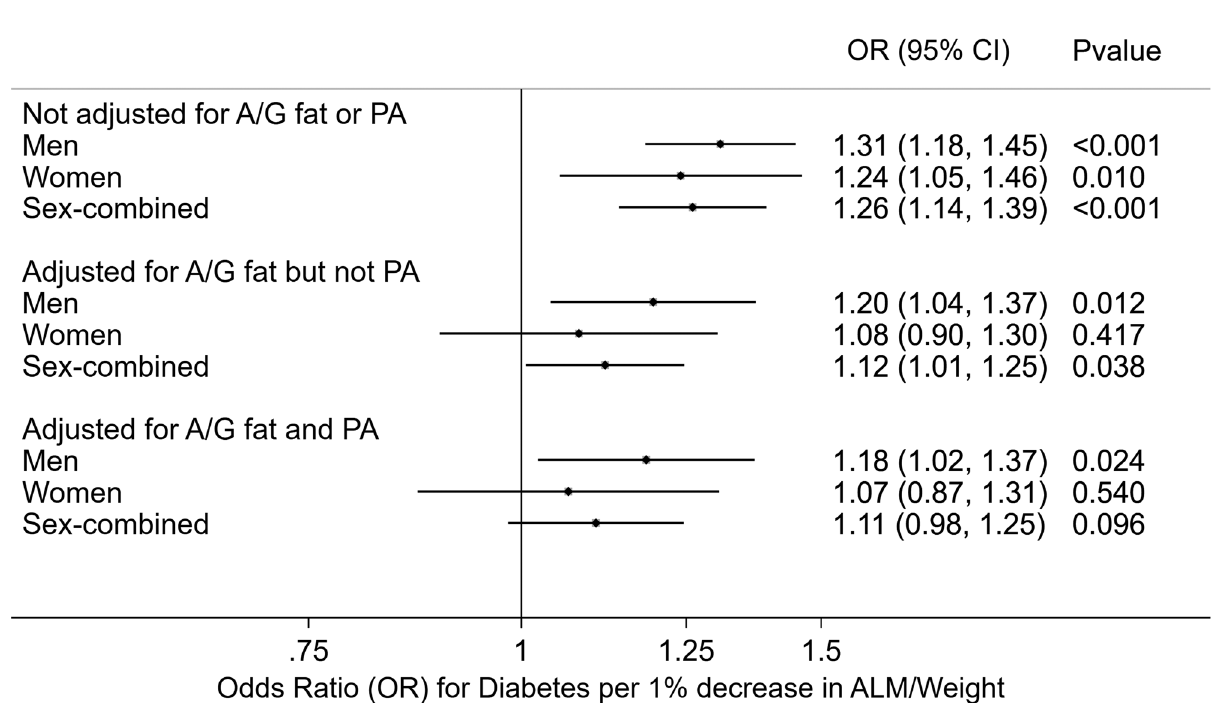
Grey boxes signify correlations in men. White boxes signify correlations in women. All correlations are signi fi cant at p <